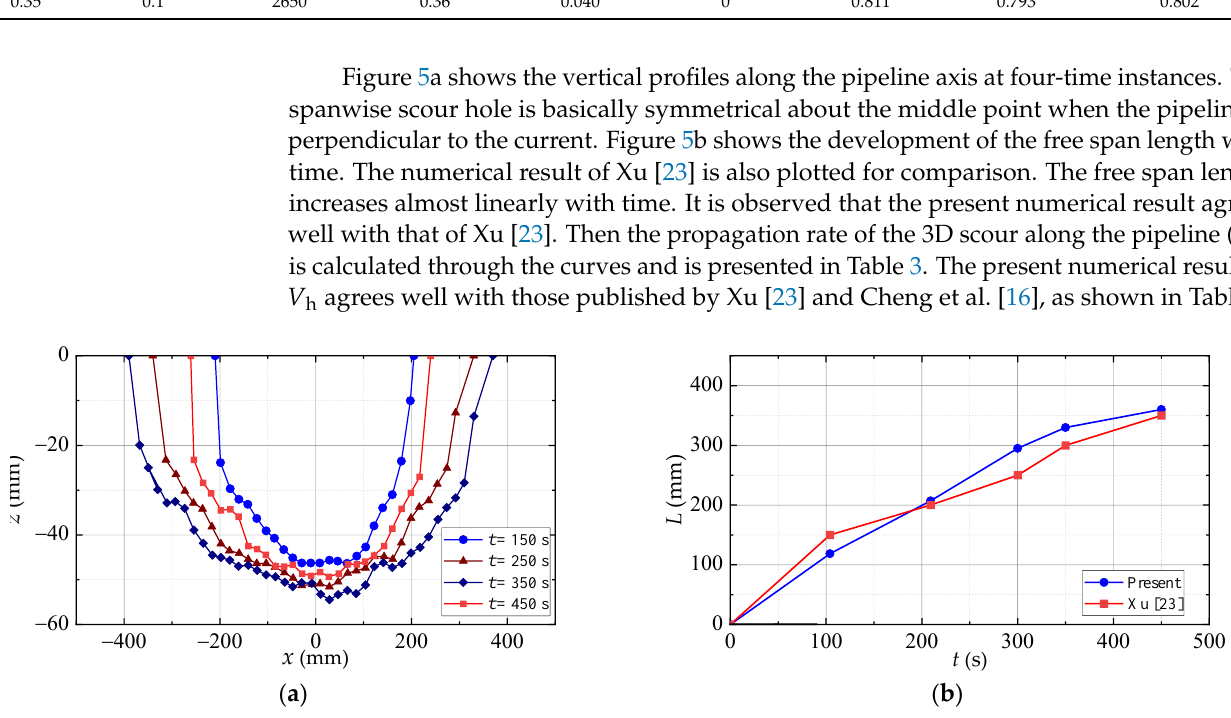
Figure 5. Numerical results of 3D scour below a pipeline, ( a ) vertical profiles along the pipeline axis, ( b ) development of span length with